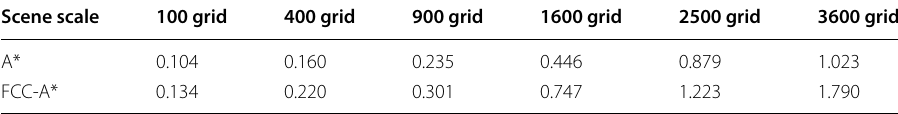
Table 3 Comparison of planning time of two algorithms (unit: seconds) Scene scale